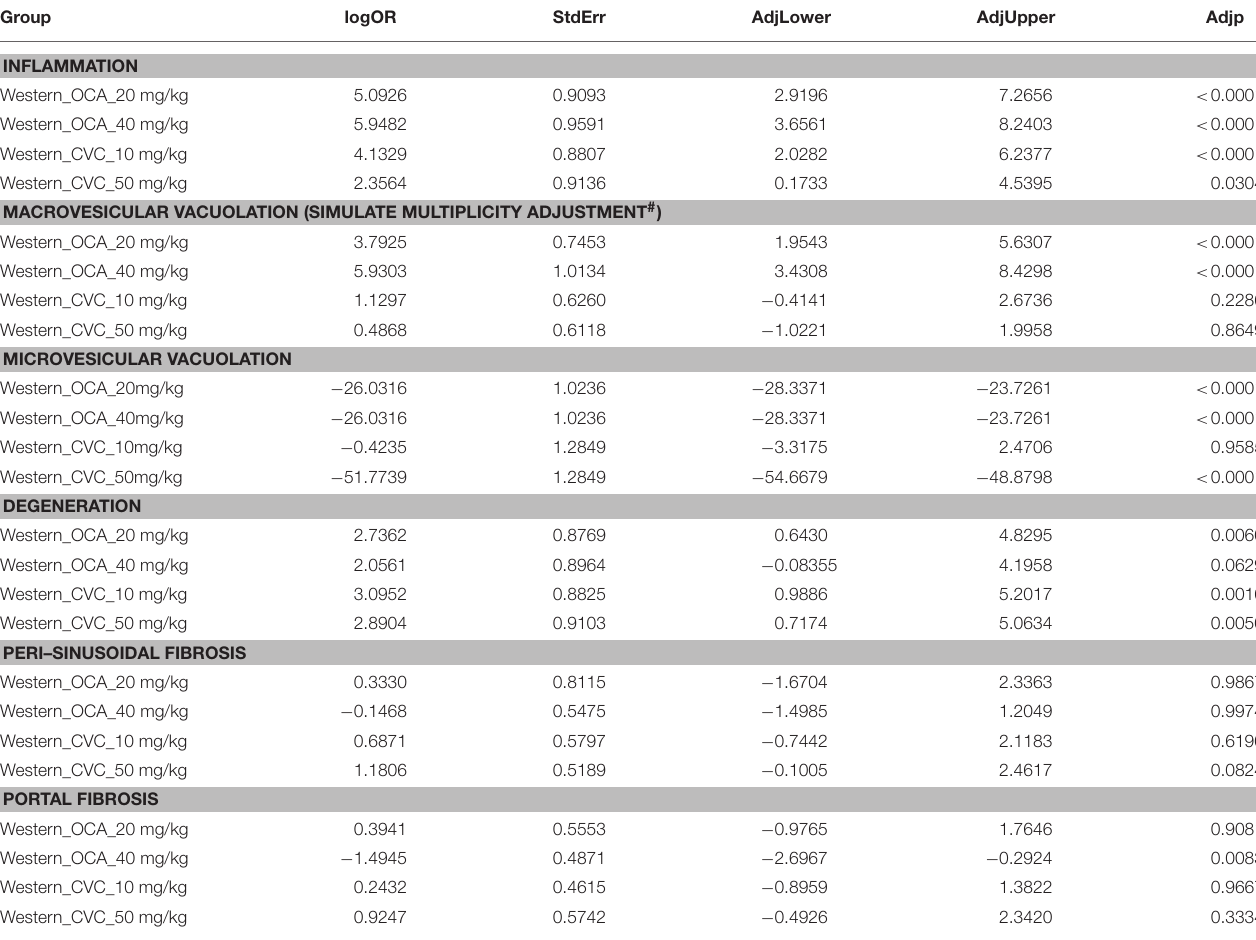
TABLE 5 | Statistical analysis of pharmacotherapy study. Group logOR StdErr AdjLower AdjUpper